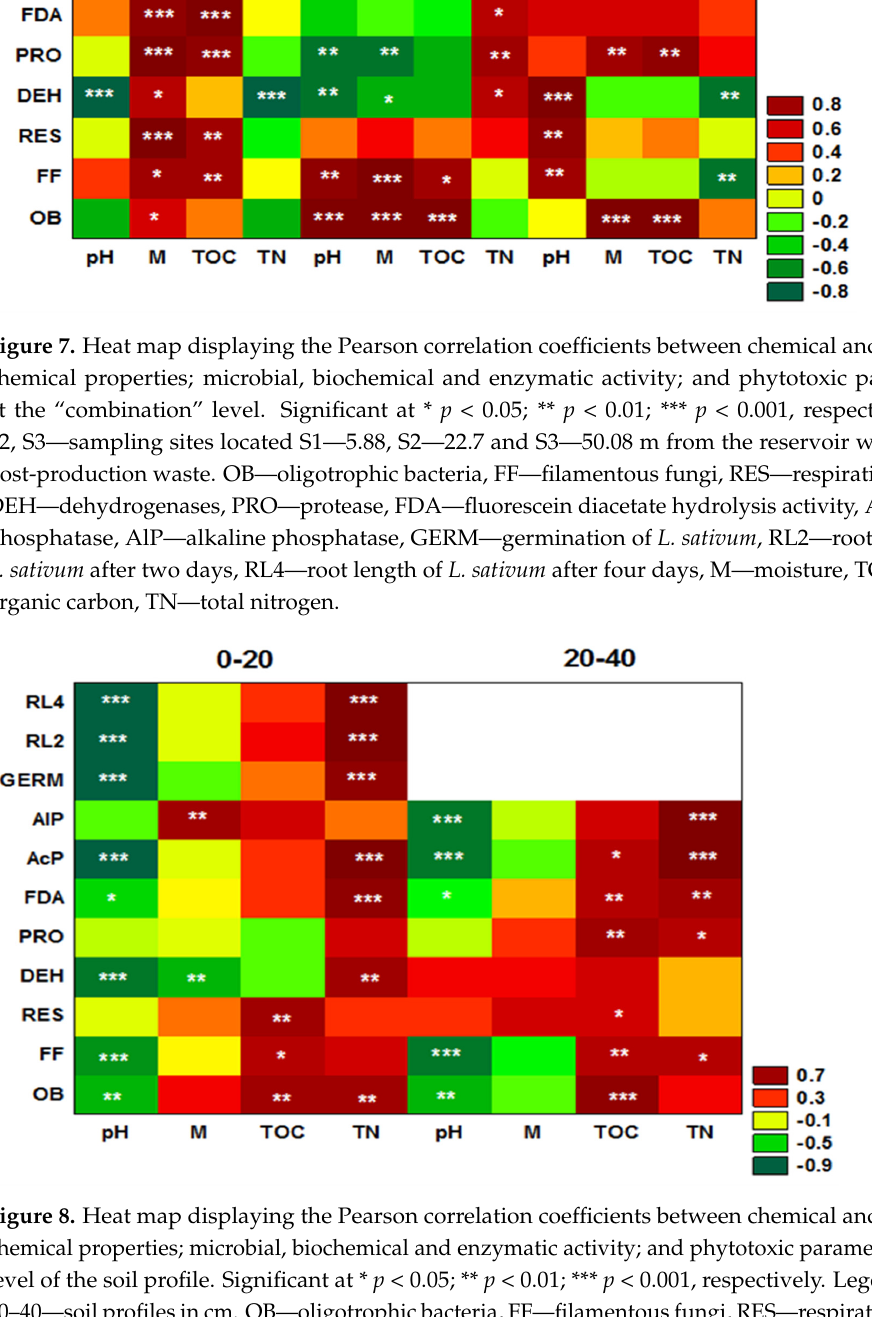
at the level of the soil profile. Significant at * p < 0.05; ** p < 0.01; *** p < 0.001, respectively.